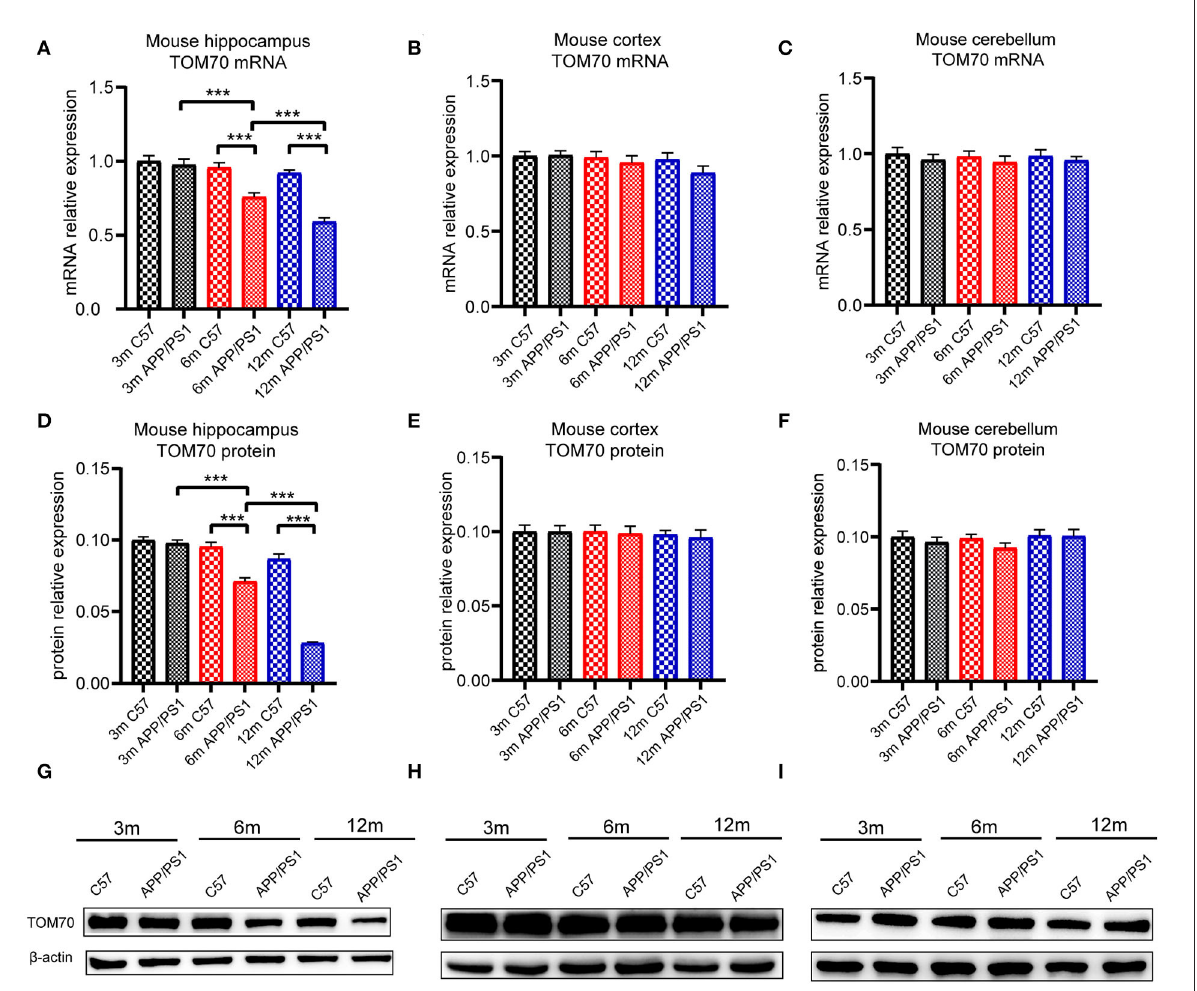
FIGURE4 TOM70 level in mouse brain tissue. TOM70 mRNA and protein levels in mouse hippocampus, cortex, and cerebellum. TOM70 level was significantly reduced in the hippocampus of APP/PS1 mice at 6 and 12 months. (A) TOM70 mRNA level in the hippocampus of APP/PS1 and C57 mice aged 3, 6, and 12 months. (B) TOM70 mRNA level in the cortex of APP/PS1 and C57 mice aged 3, 6, and 12 months. (C) TOM70 mRNA level in the cerebellum of APP/PS1 and C57 mice aged 3, 6, and 12 months. (D) TOM70 protein levels in the hippocampus of APP/PS1 and C57 mice aged 3, 6, and 12 months. (E) TOM70 protein levels in the neocortex of APP/PS1 and C57 mice aged 3, 6, and 12 months. (F) TOM70 protein levels in the cerebellum of APP/PS1 and C57 mice aged 3, 6, and 12 months. (G) Representative western blotting bands of mouse hippocampus. (H) Representative western blotting bands of mouse cortex. (I) Representative western blotting bands of mouse cerebellum. Unpaired Student’s t- test. n = 6 samples. m = month. Bar graph is expressed as mean ± SEM. * P < 0.05. ** P < 0.01. *** P < 0.001.